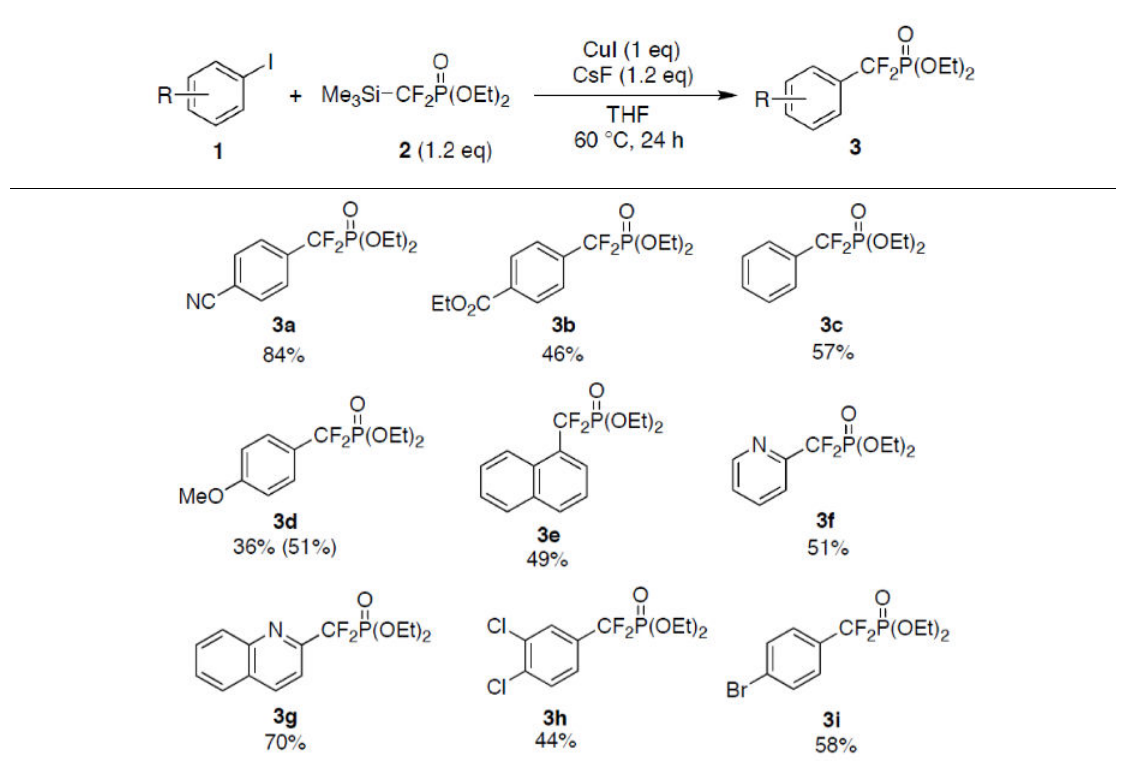
CuI-mediated cross-coupling of iodoarenes 1 with [(trimethylsilyl)difluoromethyl] phosphonate ( 2 ) 1–3